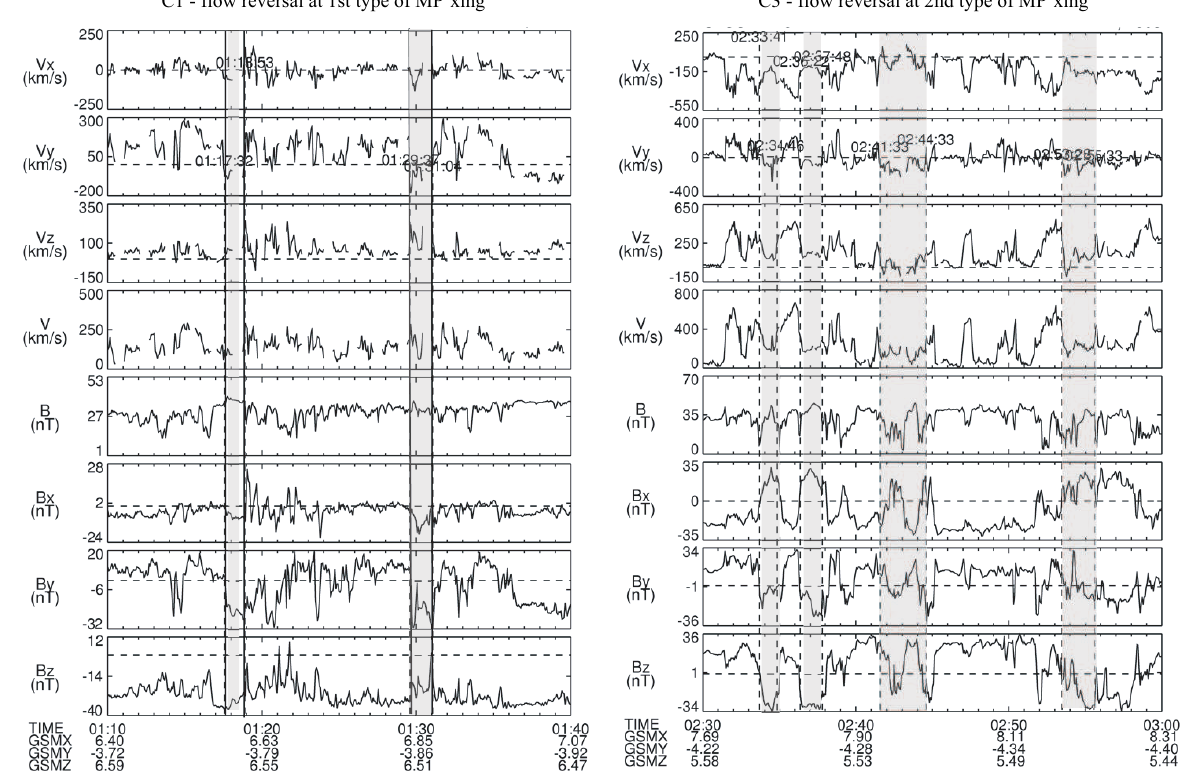
Fig. 6. Flow reversals in the y component of the ion bulk flow are shown for two types of magnetopause crossings. The left and the right panels are for the first and second type of crossing respectively. The shaded regions in the plot are used to highlight the magnetosheath region where the flow has negative V y , opposite to that of the magnetopause and its boundary